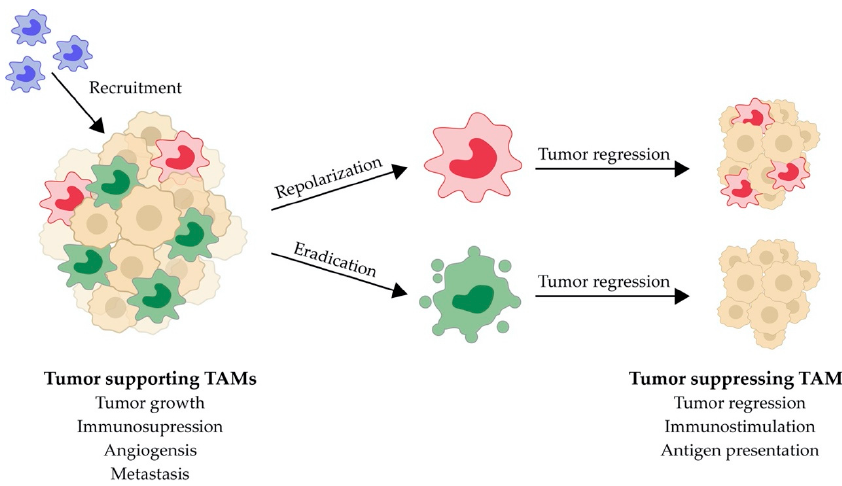
Figure 1. Targeting strategies of tumor associated macrophages (TAMs) in cancer therapy. Some of the tumor recruited macrophages adopt a tumor ‐ supportive phenotype (green) in the